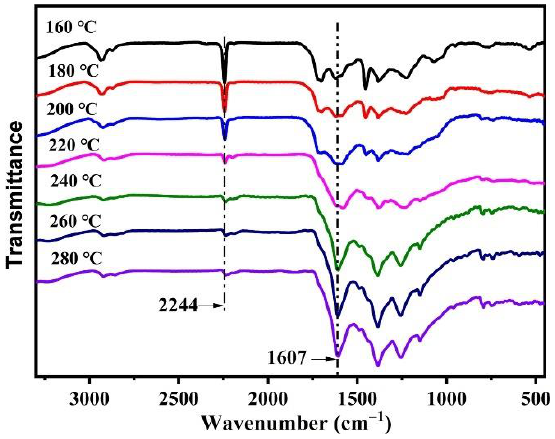
Figure 7. FTIR spectra of P (AN- co -MLA) copolymers stabilized at various temperatures for 30 min with feed ratios of AN/MLA = 97/3 (wt/wt).